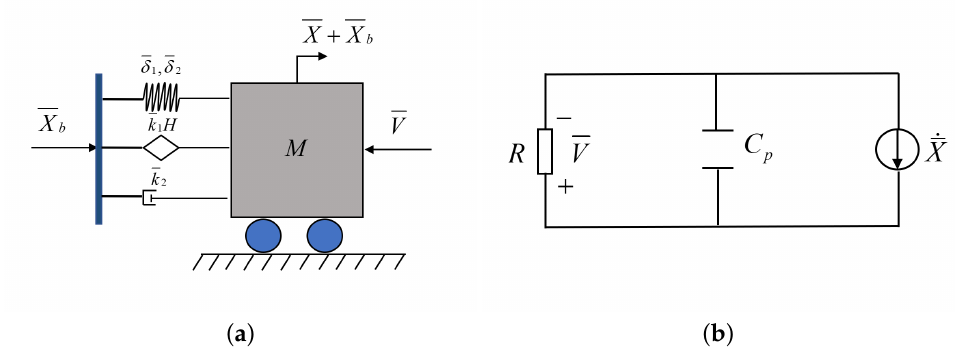
Figure 1. ( a ) A simplified diagram of a VEHS coupled with ( b ) a capacitive energy harvesting